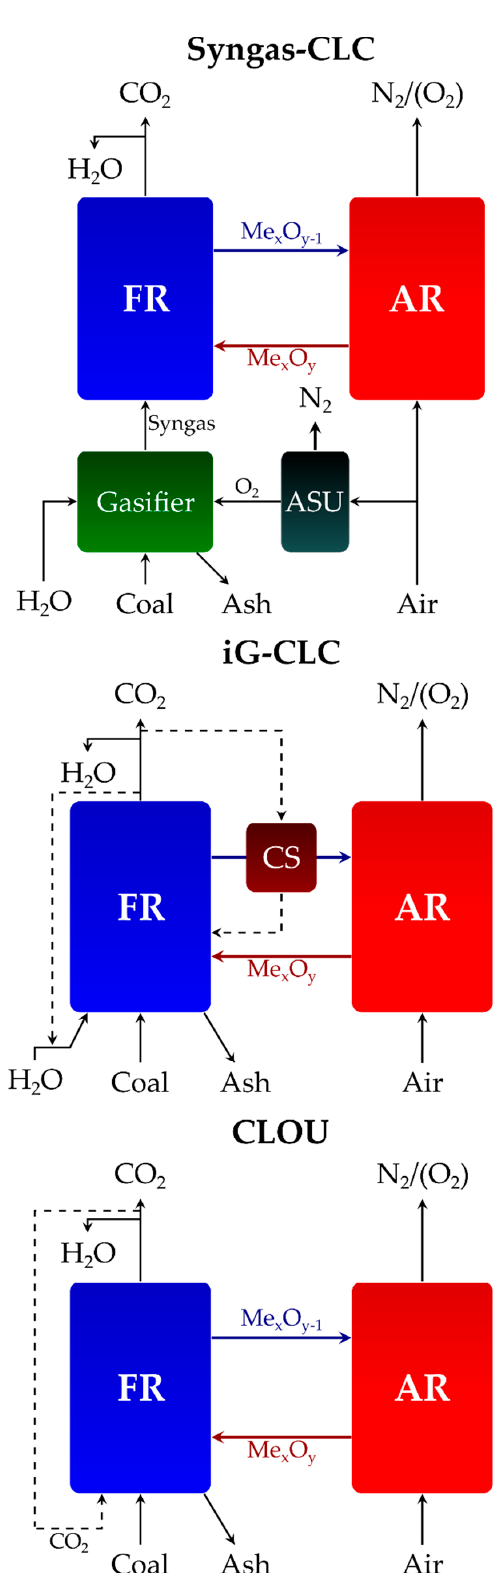
Figure 6. Chemical looping combustion processes with solid fuels, adapted from [20] and [104]. Acronyms include FR - fuel reactor, AR - air reactor / regenerator, ASU - air separation unit, CS - carbon